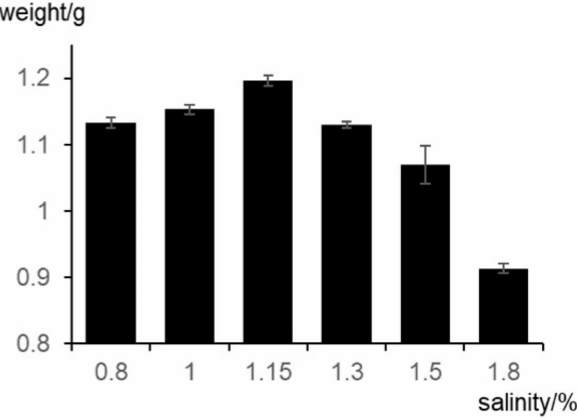
Figure 3. The e ff ect of di ff erent salinity on